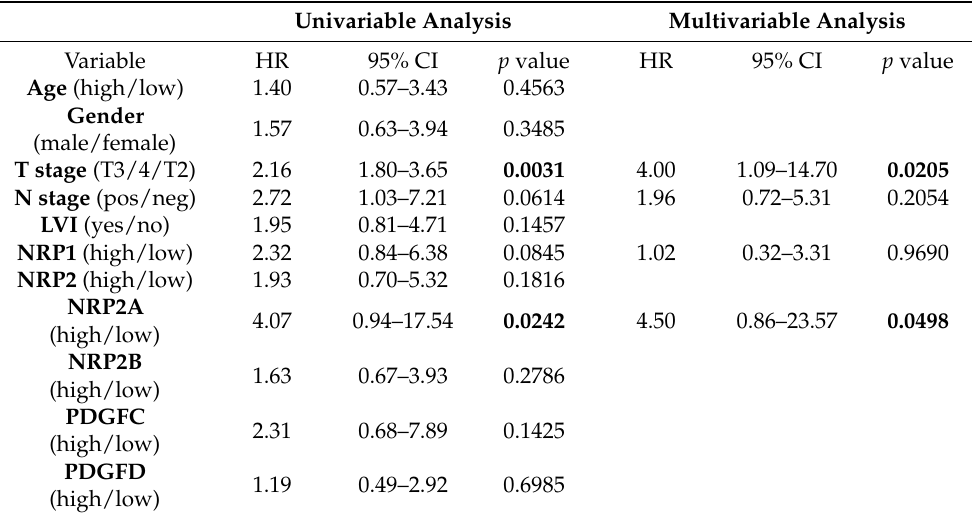
Table 6. Univariable and multivariable Cox regression analyses to test the effect of different parame- ters on cancer-specific survival in the Mannheim cohort.